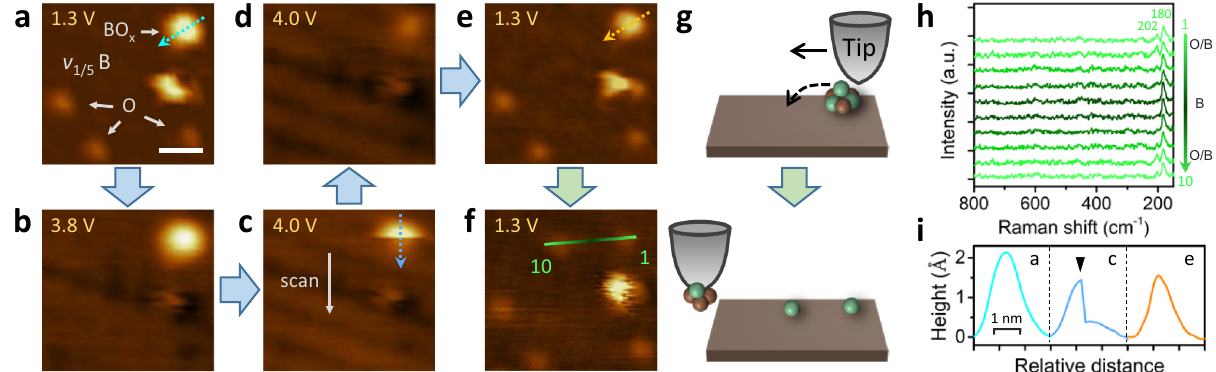
Fig. 6 STM-TERS investigations of the stability of surface adsorbates on oxidized borophene. a – f STM images acquired from the same oxidized borophene region with different sample biases as indicated. The absence of oxygen adatoms in b – d is due to the bias-dependence of STM topography rather than tip-induced desorption. White arrow in c indicates the STM scanning direction (top-down). Scale bar: 2 nm. g Schematic of tip manipulation performed in e , f . Brown and green spheres represent boron and oxygen atoms, respectively. h TERS line scan (10 points) along the green tip trace indicated in f . i Height pro fi les along the cyan ( a ), blue ( c ), and orange ( e ) dashed-line arrows. A black arrowhead marks the position of the decomposition reaction. TERS measurement parameters: 0.2 V, 2 nA, 5 s, step length ∼ 4.5 Å. Tunneling current: a – e 150 pA; f